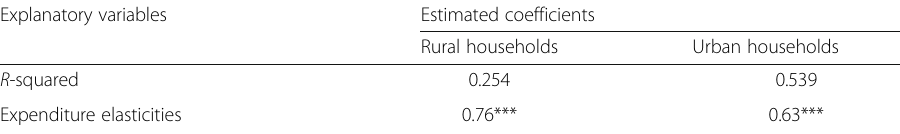
Table 3 Estimated W-L model for food consumption: first upper stage (Continued)